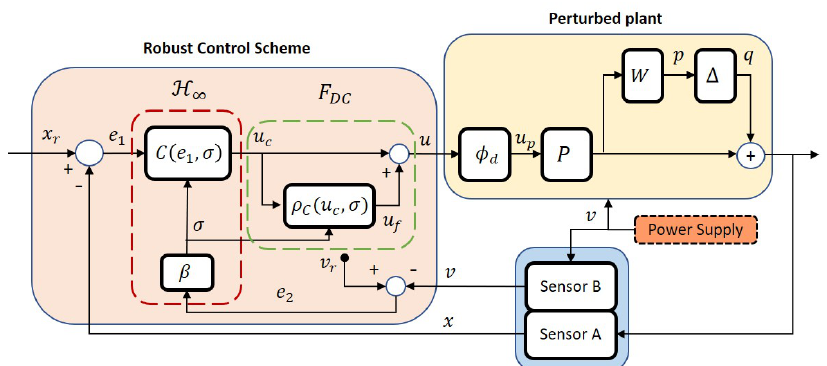
Figure 2. Overall structure of the proposed robust control system in the LLC